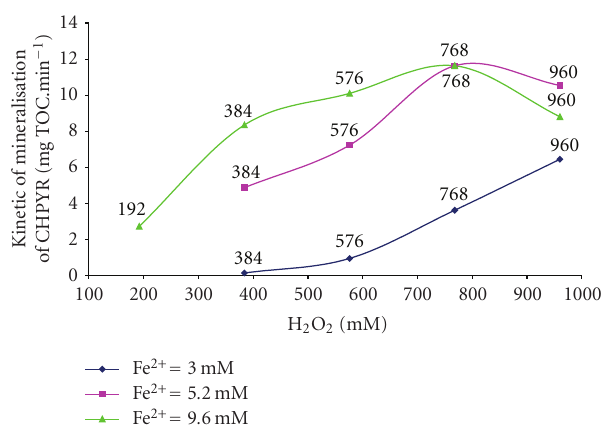
Figure 5: Kinetic of mineralisation of the CHPYR at various H 2 O 2 concentration: ( ) for 3mM; ( ) for 5.2 mM and ( ) for 9.6 mM, as a function of the H 2 O 2 concentration during the PhotoFenton process in a 50% diluted e ffl uent (42.5 mM).